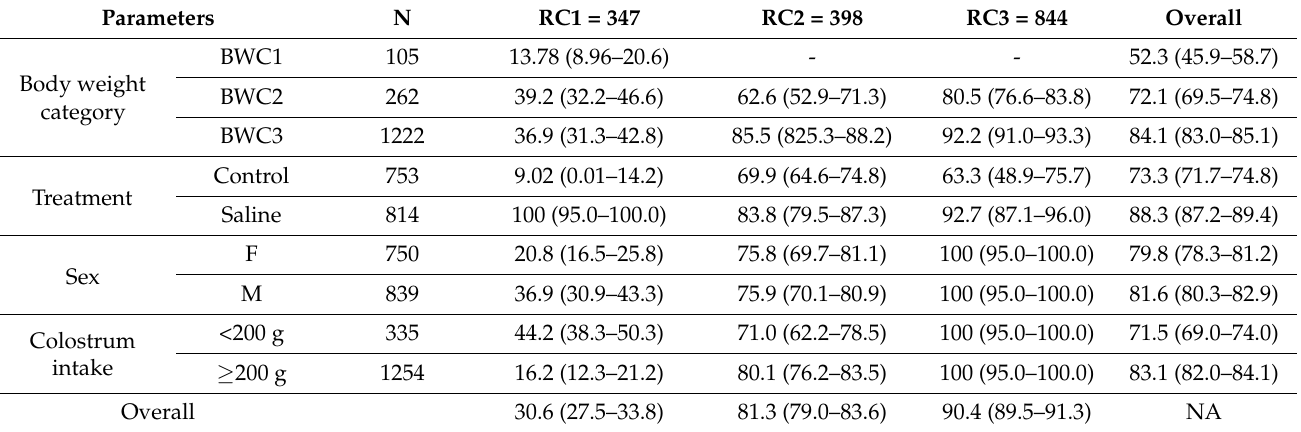
Table 4. Percentages and respective 95% confidence intervals of survival rates at 20 d for 1589 piglet observations after bootstrapping at a root of 24. RC = 1 temperature ≤ 32.0 ◦ C, RC = 2;